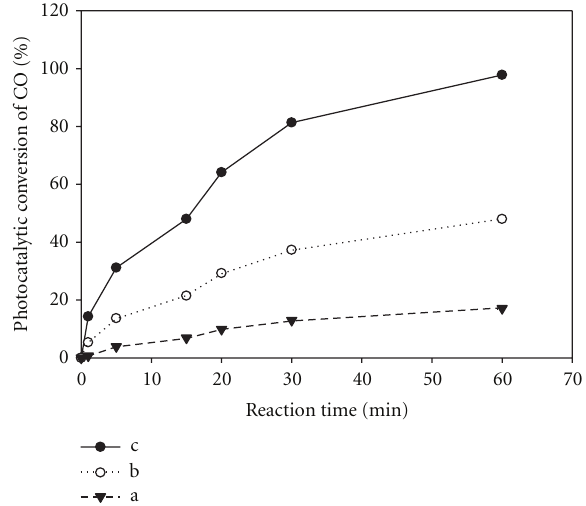
Figure 7: Photocatalytic conversion of CO (%) for Ti-HMS (a), img-Au/Ti-HMS (b) and PAD-Au/Ti-HMS